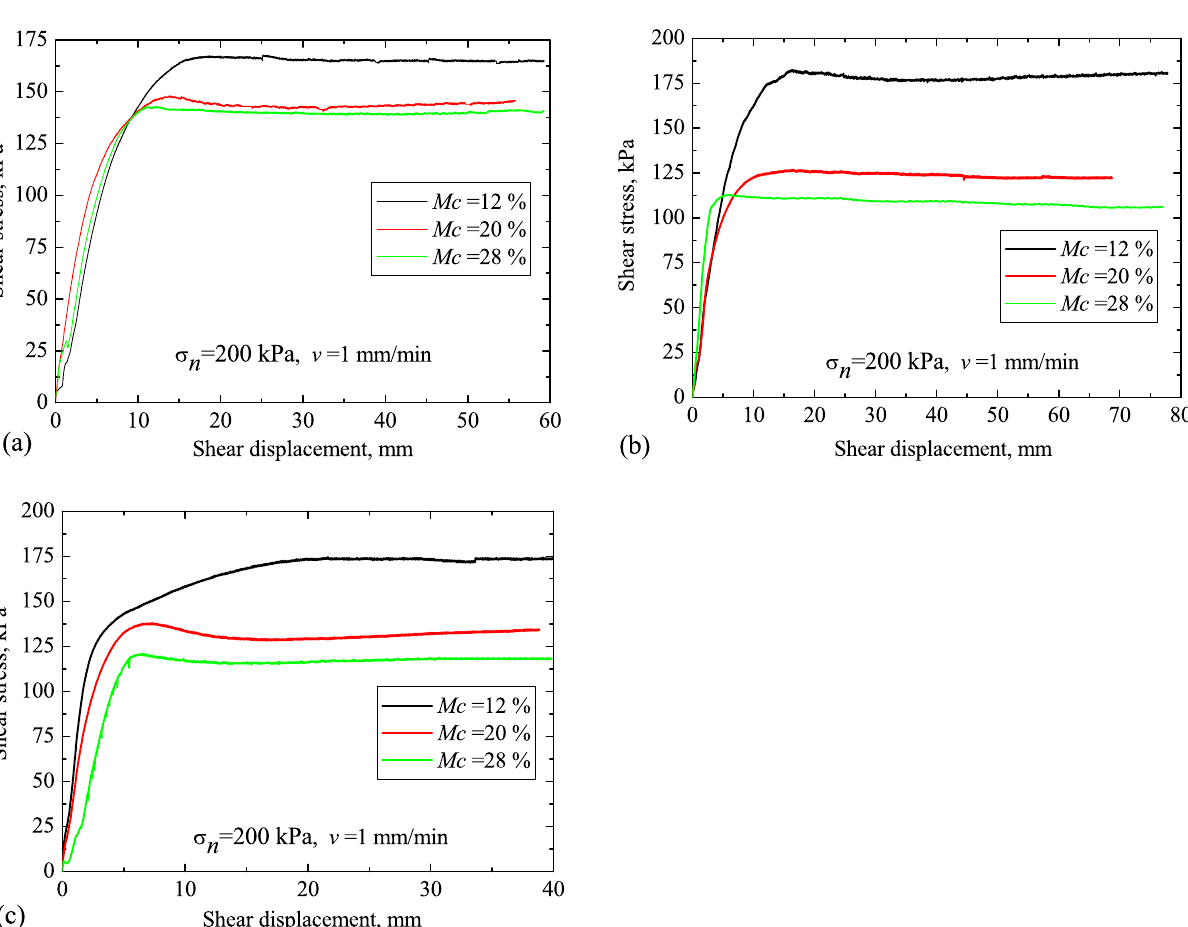
Figure 6. Stress–displacement curves under different moisture contents. ( a ) Loess; ( b ) red clay; (c)